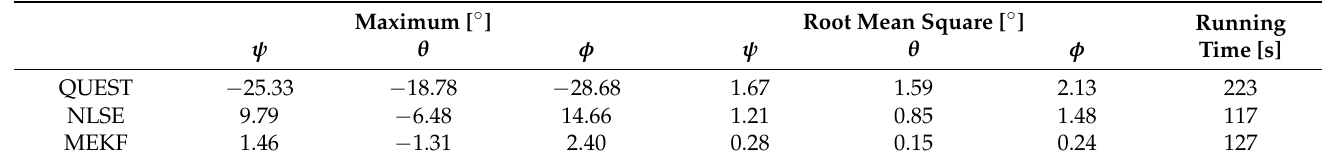
Figure 9. The estimation errors of Euler angle by QUEST ( a ), NLSE ( b ) and MEKF ( c ) methods. The statistics of all simulation results are presented in Table 2, including the maximum error, the root mean square of the estimation error and the running time of the three methods. From Table 2, we can see clearly that the MEKF method has the highest accuracy; NLSE comes second and the QUEST method is last. For running time, the NLSE method is the fastest, slightly faster than the MEKF method. The running time of the QUEST method is almost two times that of the NLSE method, which is likely caused by the two nonlinear estimations for QUEST, while NLSE has just one. Table 2. The statistics of all simulation results.